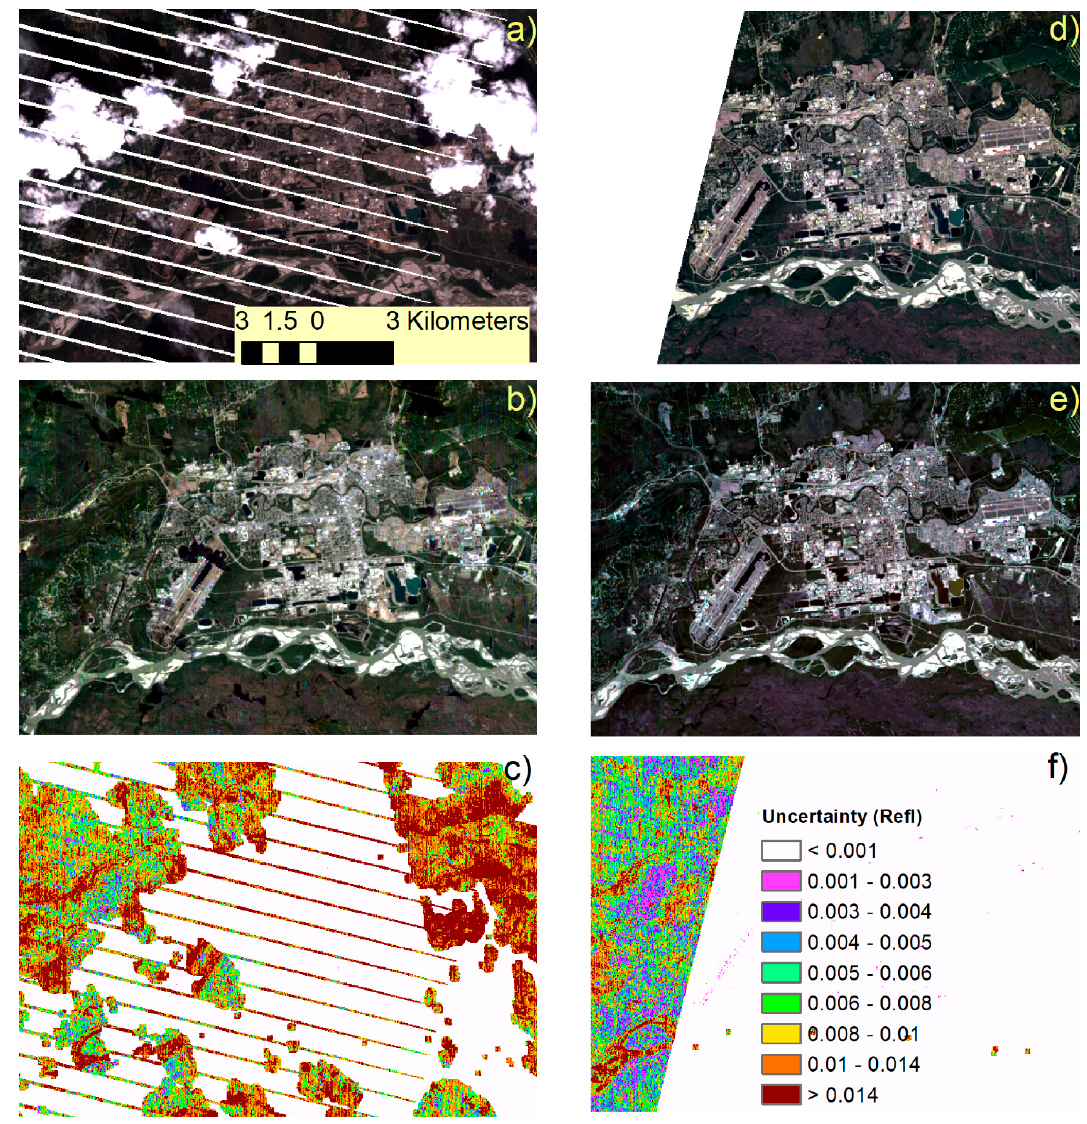
Figure 7. Fairbanks (Alaska) gap-filling example, 689 × 472 30-m pixel area. Panel ( a ) shows ARD raw image from 5 June 2017, with the true color combination and ( b ) gap-filled image. Panel ( c ) shows the uncertainty of model predictions with the red band. Panels ( d ) and ( e ) show the same group of images from 6 June 2017.